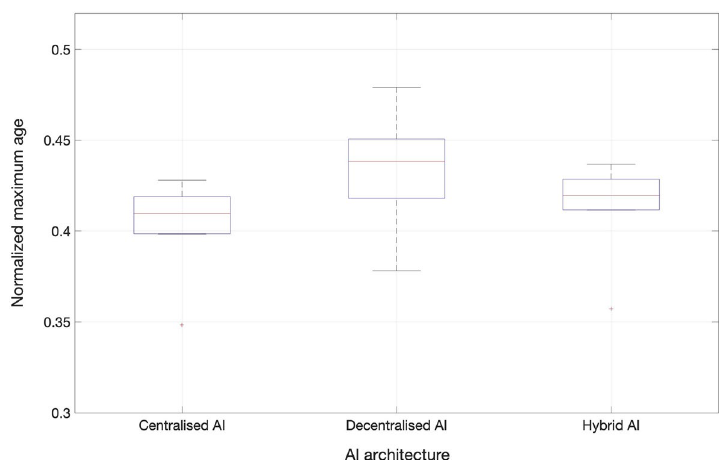
Fig. 9 Comparison of the three learning approaches based on maximum age reduction over PF systems